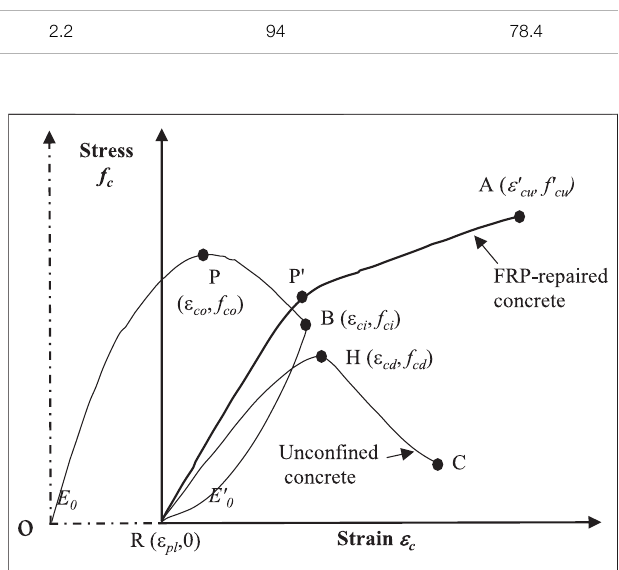
Figure 3 | Typical stress-strain curves for uncon fi ned and con fi ned